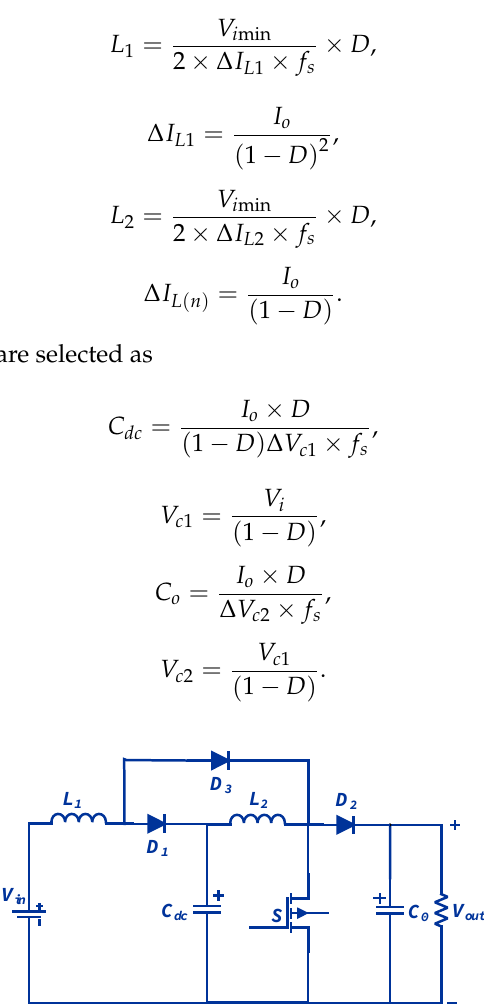
Figure 7. Configuration of Quadratic Boost Converter.